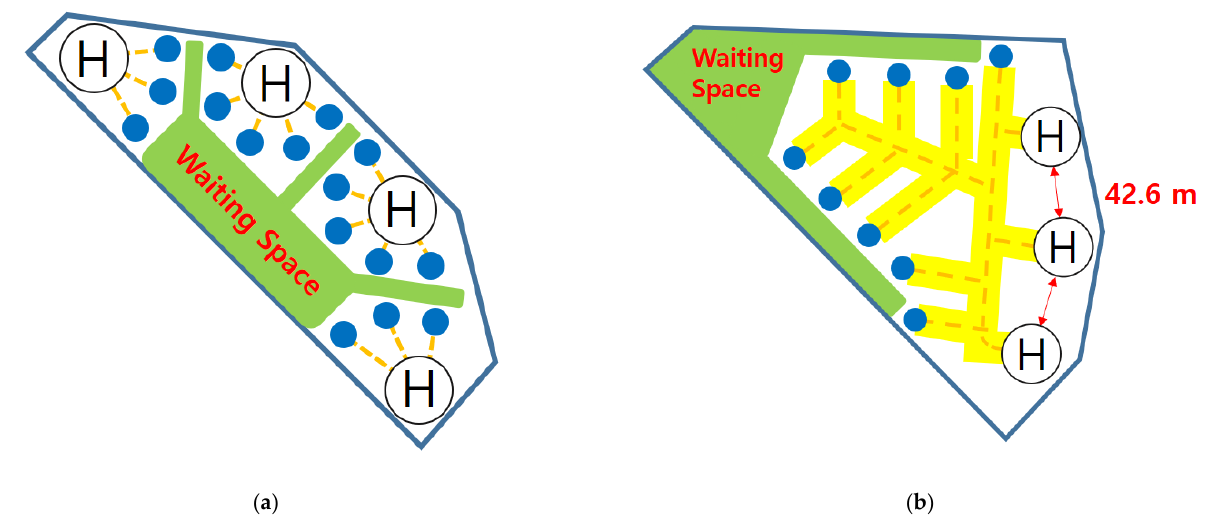
Figure 19. Satellite topologies for the Gimpo Airport parking lot that comply with the FAA’s new regulations: ( a ) current parking space; ( b ) expanded parking space.